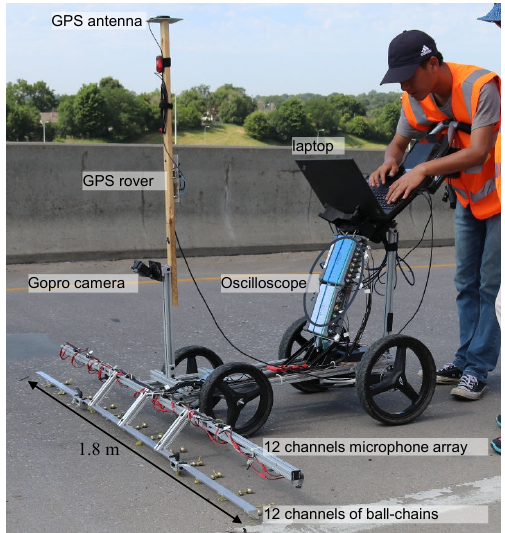
Figure 1. 12-channel acoustic scanning